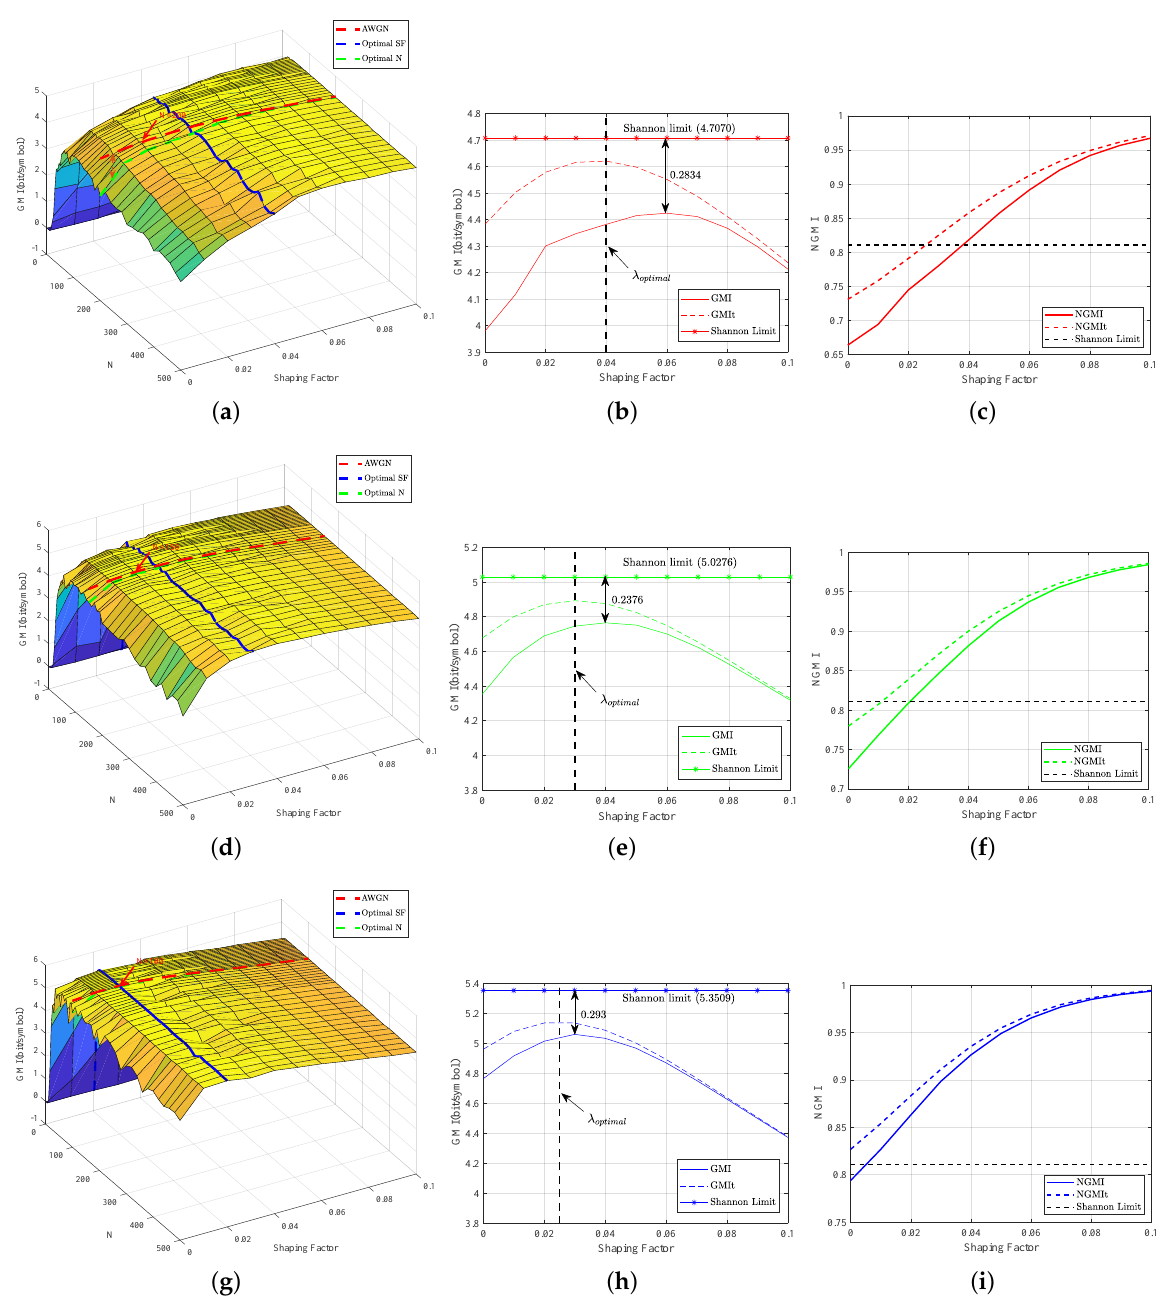
Figure 4. Optimization results for SNR of 14 dB: ( a ) GMI performance results as a function of N and SF; ( b ) GMI performance at optimized N; ( c ) NGMI performance at optimized N, 16 dB; ( d ) GMI performance results as a function of N and SF; ( e ) GMI performance at optimized N; ( f ) NGMI performance at optimized N, 18 dB; ( g ) GMI performance results as a function of N and SF; ( h ) GMI performance at optimized N; ( i ) NGMI performance at optimized